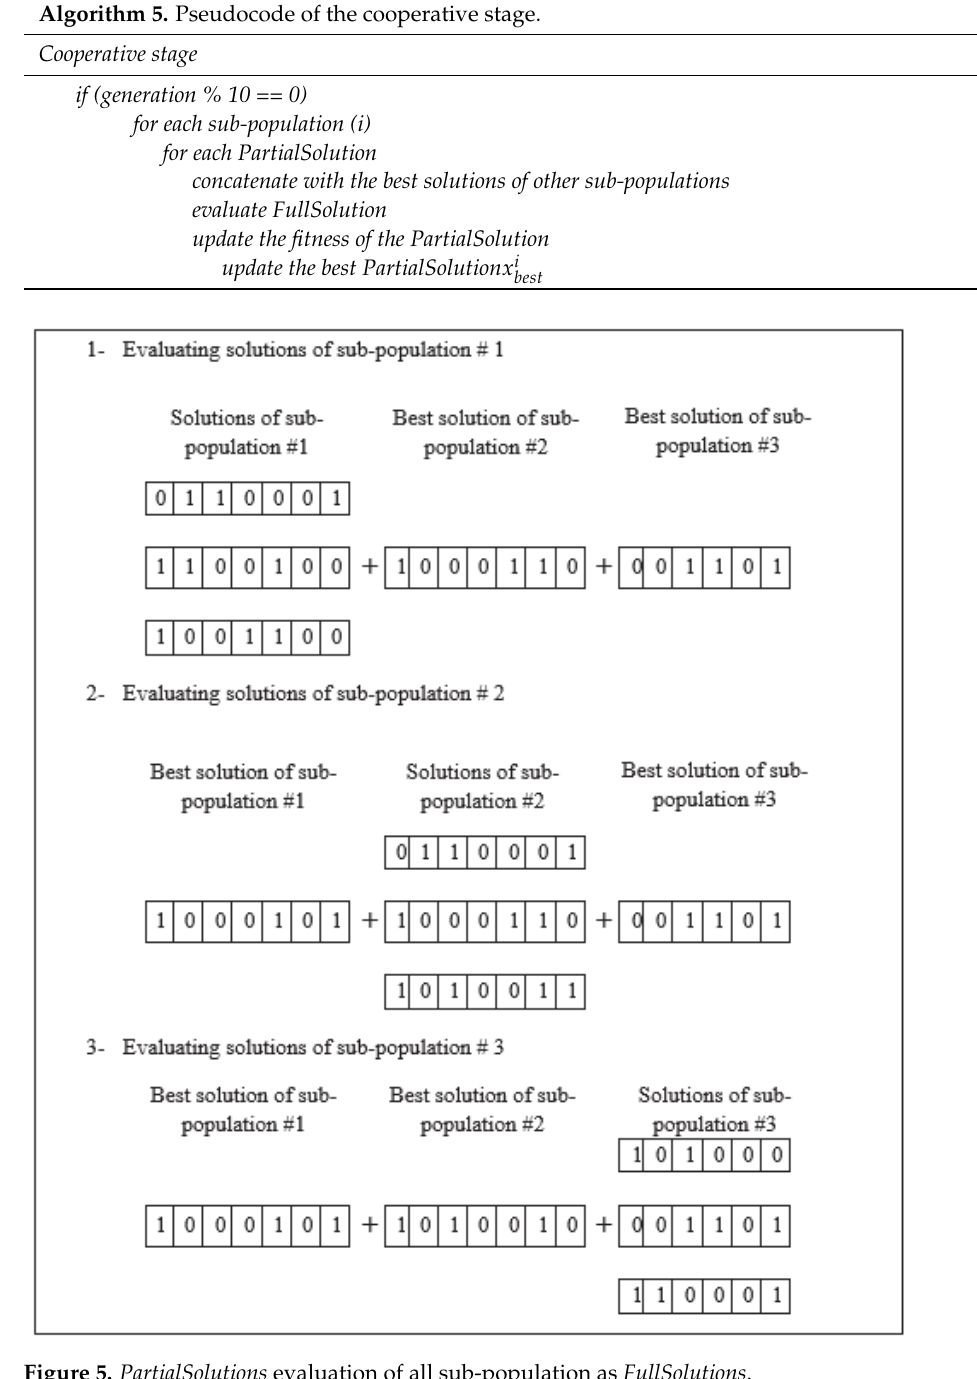
Algorithm 5. Pseudocode of the cooperative stage.